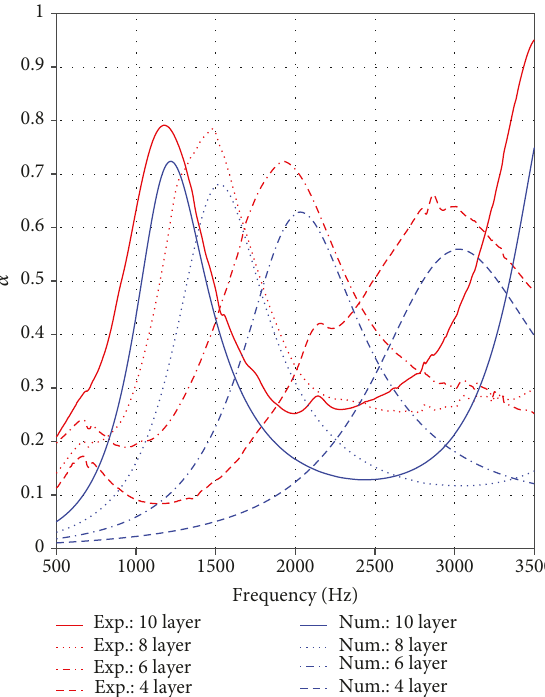
Figure 10: Absorption coe ffi cient for 4, 6, 8, and 10 layers deep of the DENORMS cell printed on the SLA Form 2 (red: experimental results; blue: numerical results).